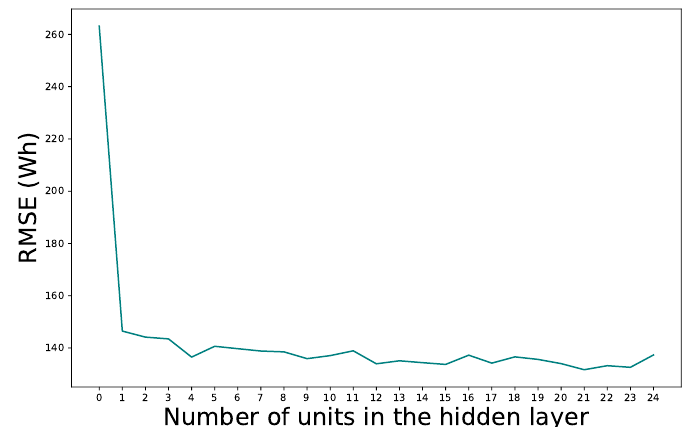
Figure 5. RMSE vs. number of